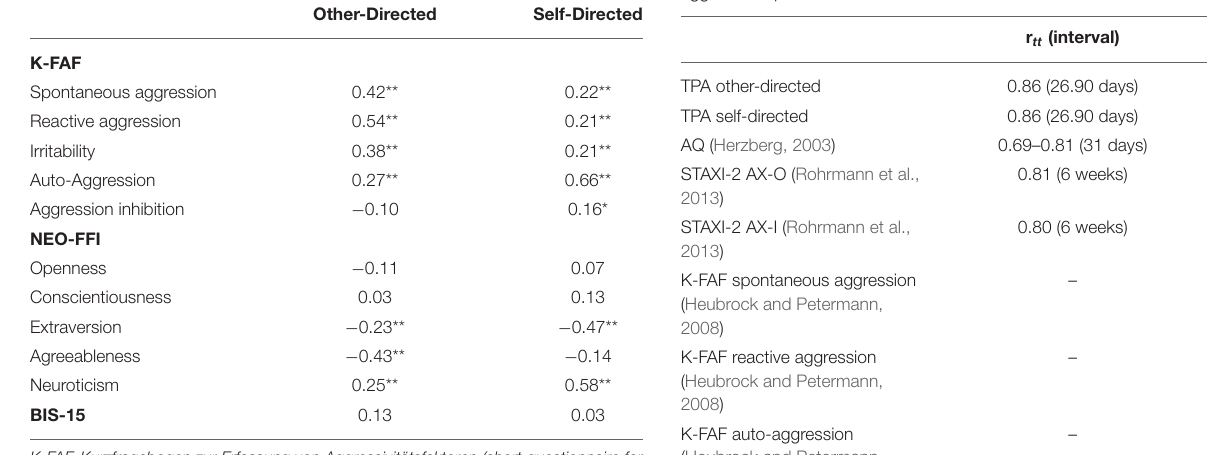
TABLE 10 | Construct validity of the TPA scales. TABLE 11 | Examples for retest-reliabilities and internal consistencies of aggression